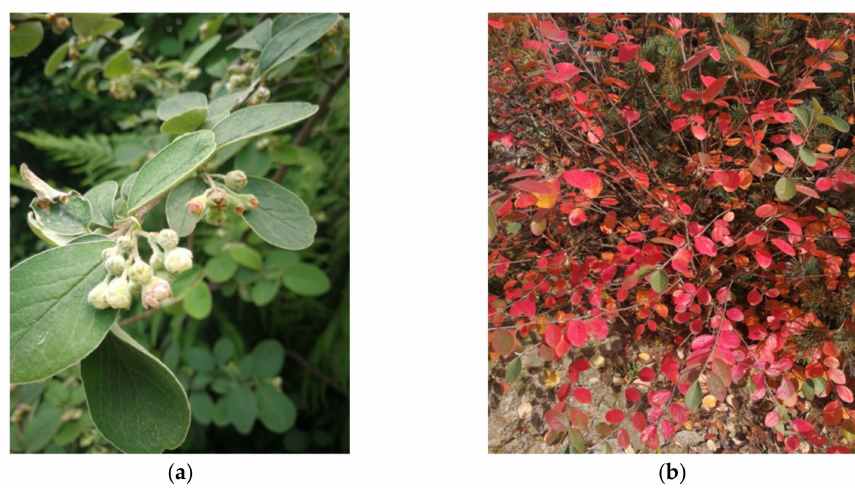
Figure 9. C. nebrodensis in the UMCS Botanical Garden of Maria Curie-Skłodowska University in Lublin taken in May ( a ) and in October ( b ).